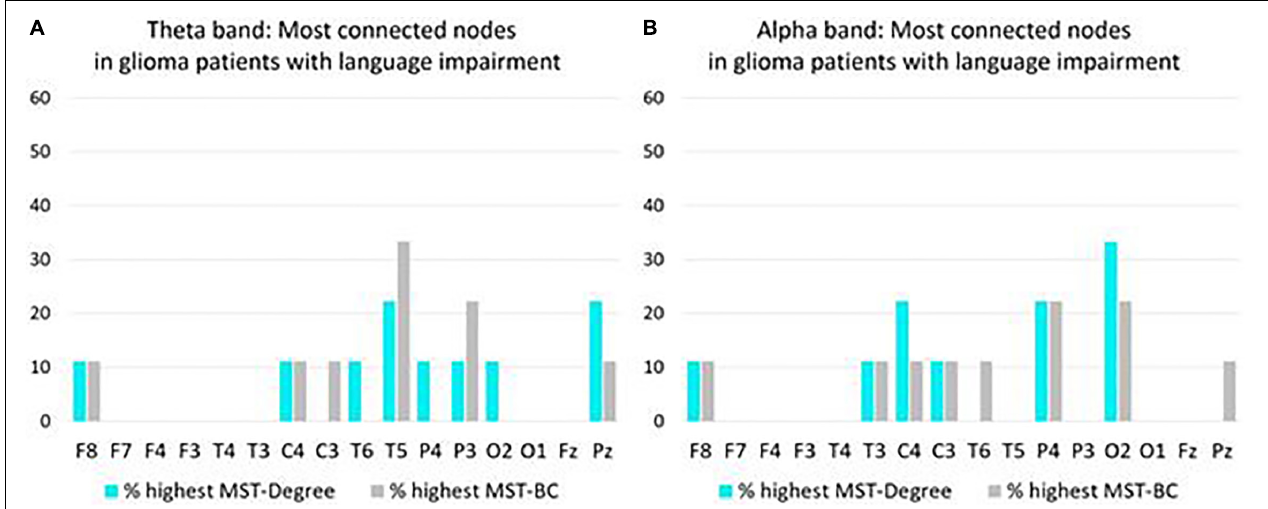
FIGURE 2 | Overview of most connected nodes in MST networks in the theta band (A) and in the alpha band (B) in preoperative glioma patients with language impairment ( N = 9). For each node, the y -axis expresses the percentage of patients who have the highest Degree/Betweenness Centrality (BC) ranking for that node in their MST network. If a patient’s network has two or more nodes with a shared highest ranking, all shared highest rankings are included in the